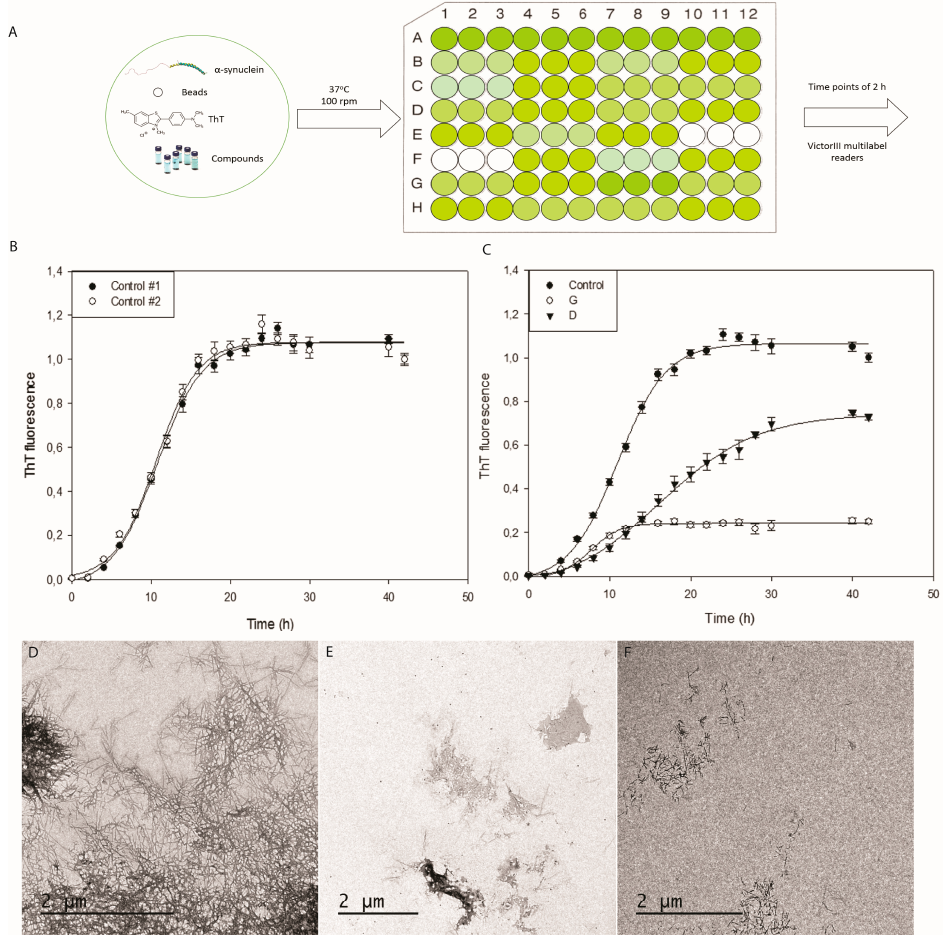
Figure 4. Aggregation kinetics, from plate preparation to putative inhibitors. ( A ) General scheme for plate preparation and incubation; ( B ) α -synuclein aggregation kinetics performed on non-consecutive days; ( C ) α -synuclein aggregation kinetics in presence of putative inhibitors. Measured by Th-T fluorescence emission, represented as normalised means. Error bars are represented as standard error.